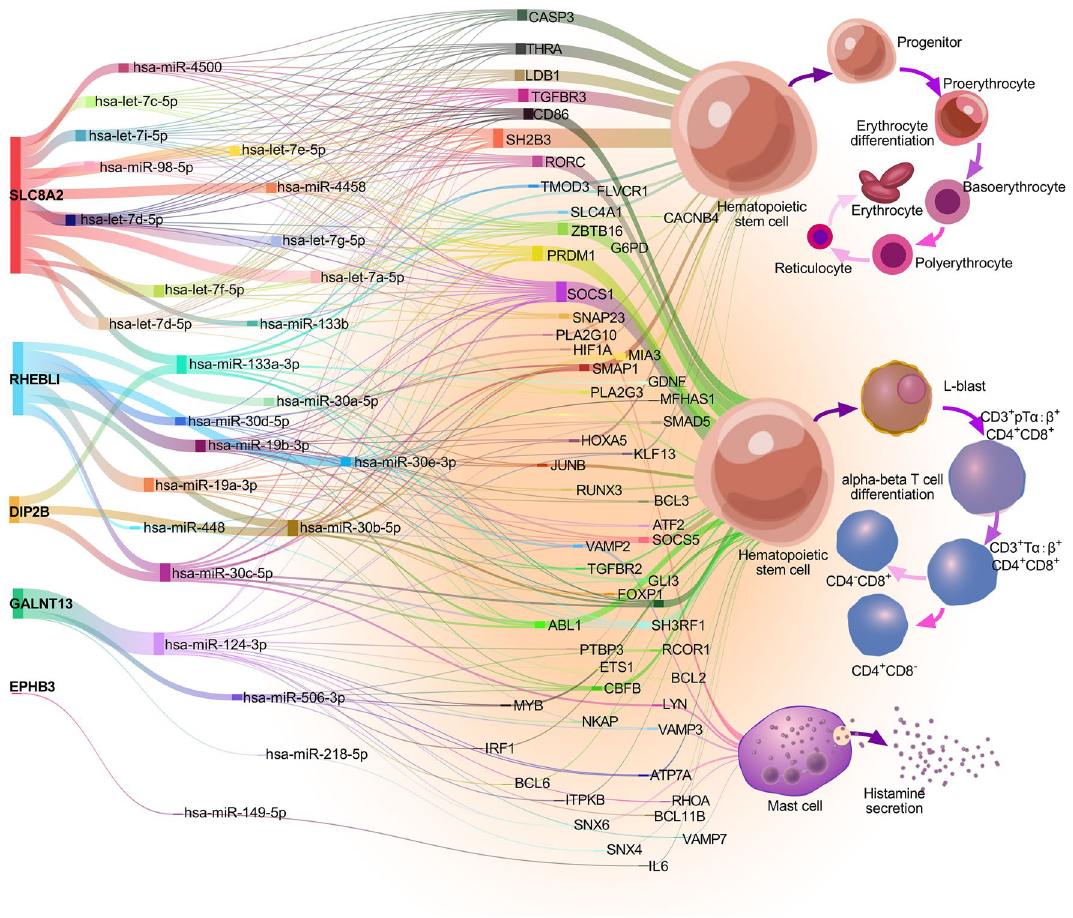
Figure 8. The identified pathways related to erythrocyte differentiation, alpha-bata T cell differentiation, and histamine secretion by mast